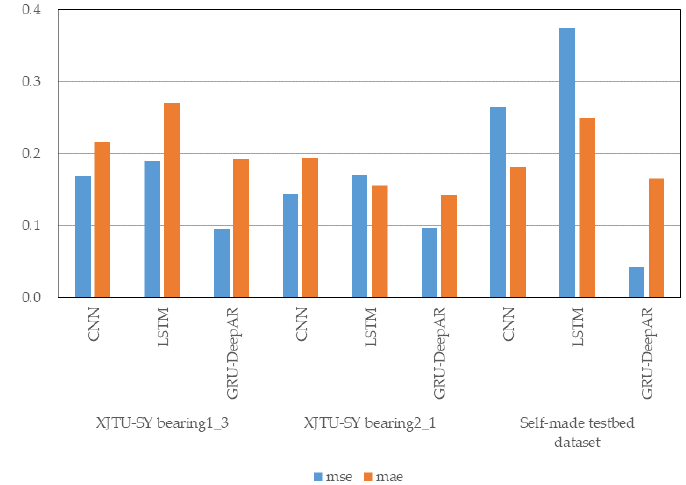
Figure 14. Comparison of prediction accuracy of different